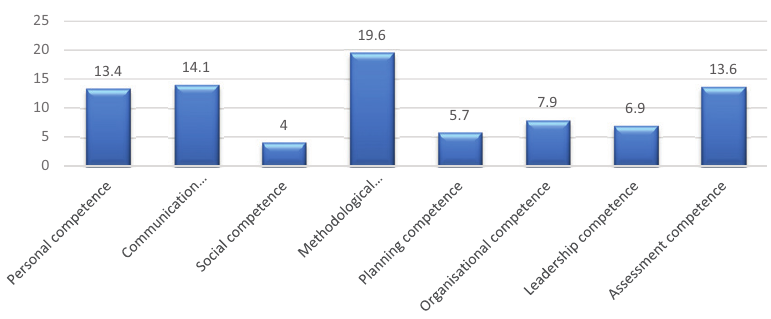
Figure 4. The need for improvement of competences (source: created by